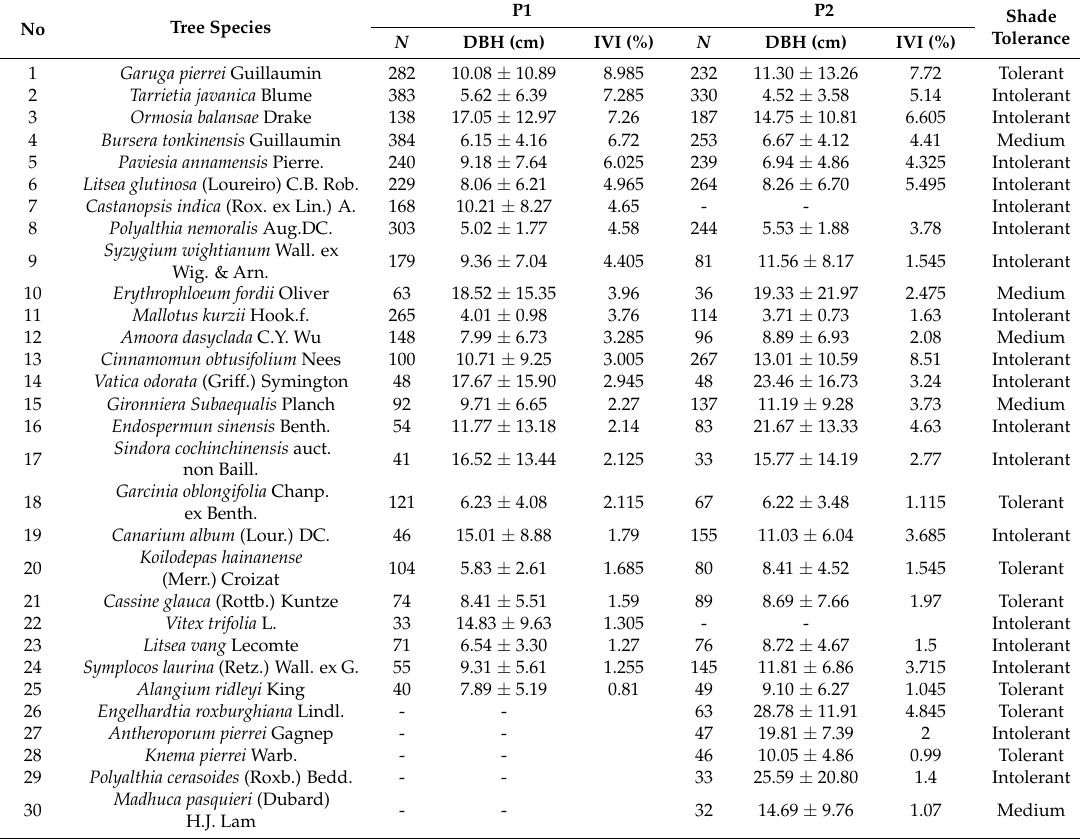
Table A1. Characteristics of common species in both study plots. N—number of individuals, IVI—Important Value Index, (relative abundance + relative basal area)/2, expressed as percentage proportion. DBH—Diameter at Breast Height (mean ± Standard